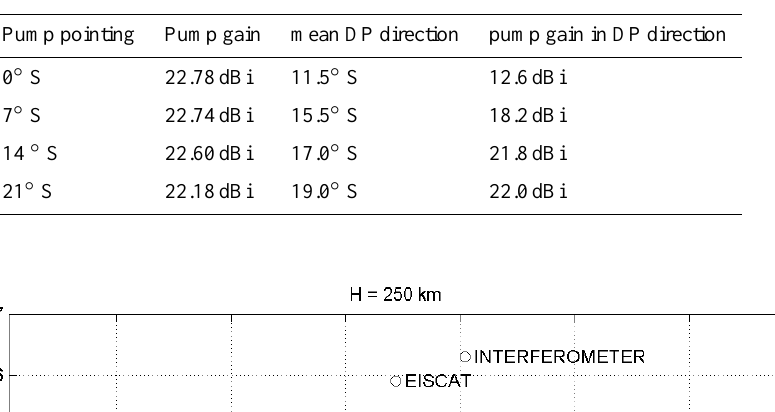
Table 1. Calculated antenna gains compared to an isotropic radiator (in dBi) for the main beam direction and the mean direction where the DP was found.